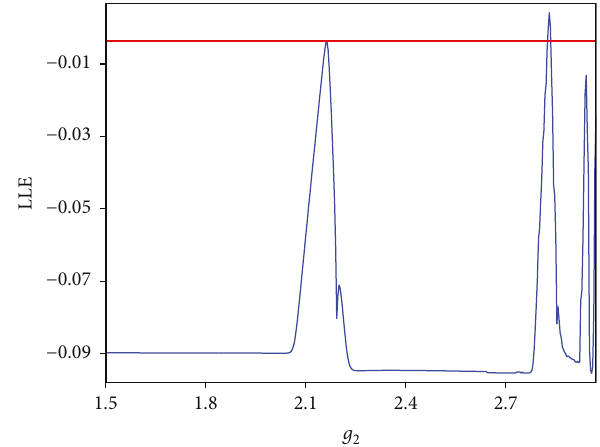
Figure 9: The largest Lyapunov exponent of the system with respect to g 2 ∈ 1 5, 2 98 . ∈ 1 5, 2 98 . 1 , k 2 , w 1 , w 2 when g 2